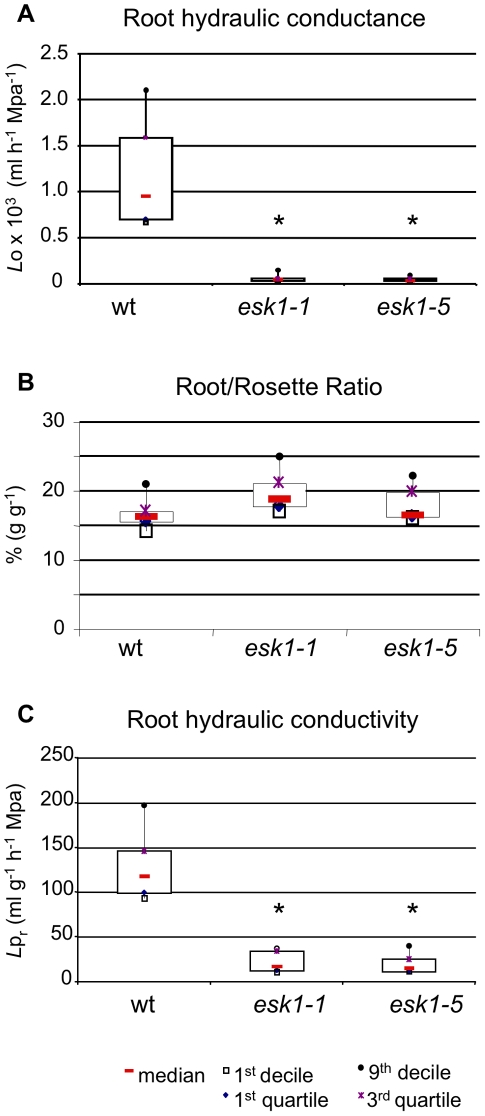
Hydraulic parameters of the root apparatus are modified in esk1.
A. Root hydraulic conductance Lo is expressed as ml of sap exudate per hour and per unit of exerted pressure. B. Root/rosette dry weight ratio. C. Root hydraulic conductivity is expressed as Lo per unit of root mass. Wild type (wt). Black * indicates significant difference with wt (p-value<0.05).